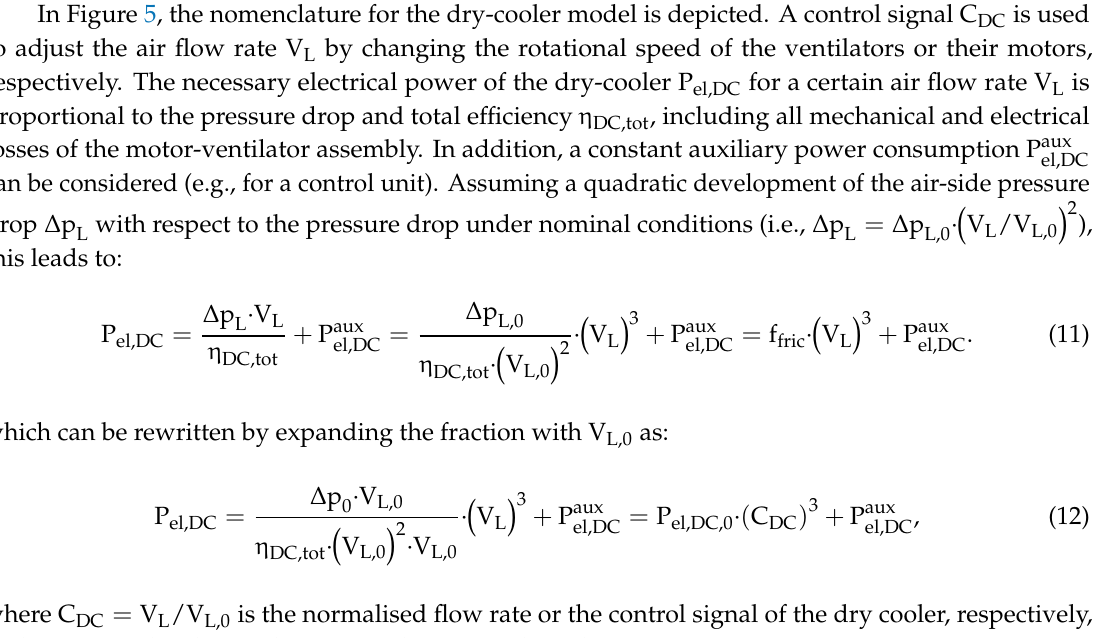
Figure 5. Nomenclature for dry-cooler model.